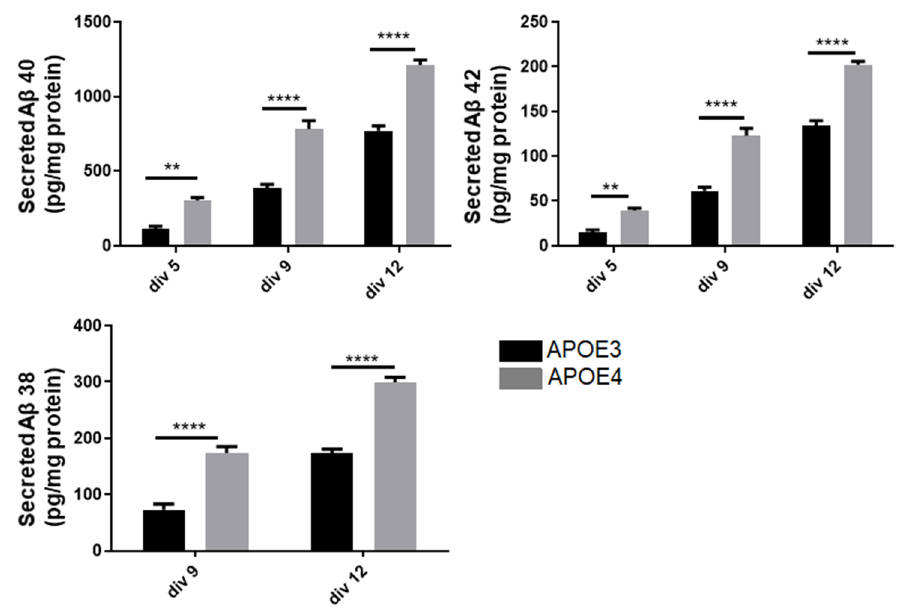
Figure 5. Effects of APOE genotype on Aβ level in primary neurons. Primary cortical neurons cultures were obtained from P0-P1 newborn KI mice carrying the human APOE3 or APOE4 alleles. After 5, 9 or 12 days in culture (DIV5, DIV9 and DIV12), levels of Aβ38, Aβ40 and Aβ42 were assessed in the culture medium using the MSD multiplex ELISA (pg/mg of proteins measured in cells lysates). Statistics: two-way ANOVA mean +/− SEM; **: p < 0.01, and ****: p < 0.0001, comparison with APOE3, 3 independent cultures with 2 to 3 replicates per culture.